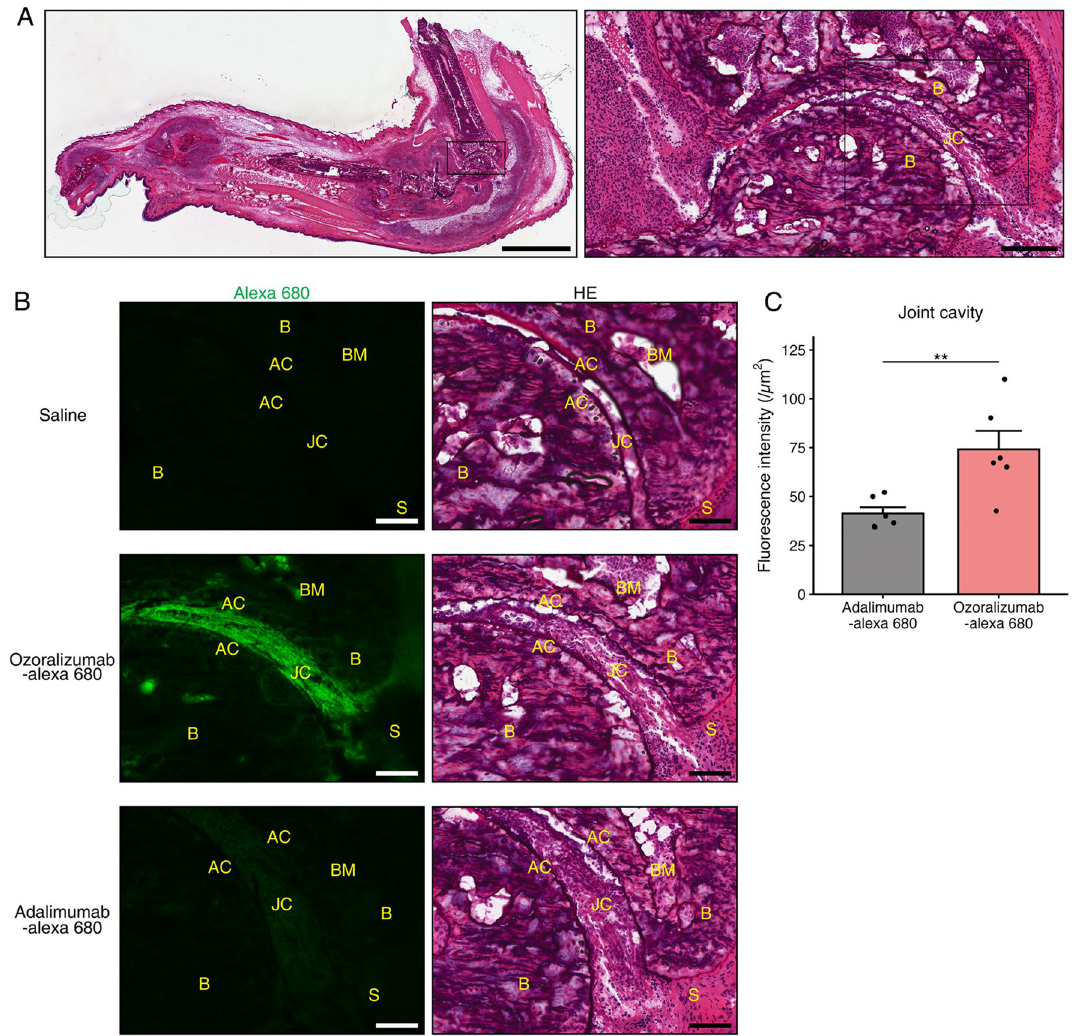
Figure 4. Fluorescence microscopy and morphometry of the talocrural joints at eight hours after a single subcutaneous injection. ( A ) Paws of the CIA mice were sectioned in the sagittal plane and stained with hematoxylin & eosin (HE). Scale bar: 2 mm (left), 200 µm (right). B: bone; JC: joint cavity. ( B ) Fluorescence microscopy of the talocrural joints eight hours after a single subcutaneous injection of ozoralizumab-Alexa 680 and adalimumab-Alexa 680. The green fluorescence represents the administered compounds labeled with Alexa 680 (left). Serial sections were stained with HE (right). Scale bar: 100 µm. B: bone; BM: bone marrow; AC: articular cartilage; JC: joint cavity; S: synovium. ( C ) The fluorescence value of Alexa 680 in the joint cavity at eight hours after subcutaneous injection was analyzed. Dot plots represent each individual data and bars represent the means ± SEM. P values were calculated using the Wilcoxon rank sum test. ** P <